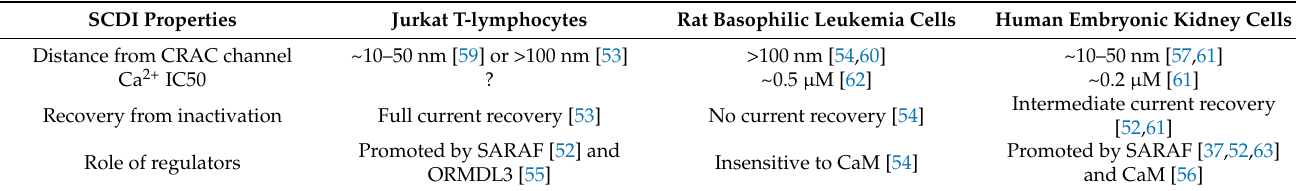
Table 1. Summary of differences in properties of SCDI in Jurkat, RBL, and HEK293 cells. SCDI Properties Jurkat T-lymphocytes Rat Basophilic Leukemia Cells Human Embryonic Kidney